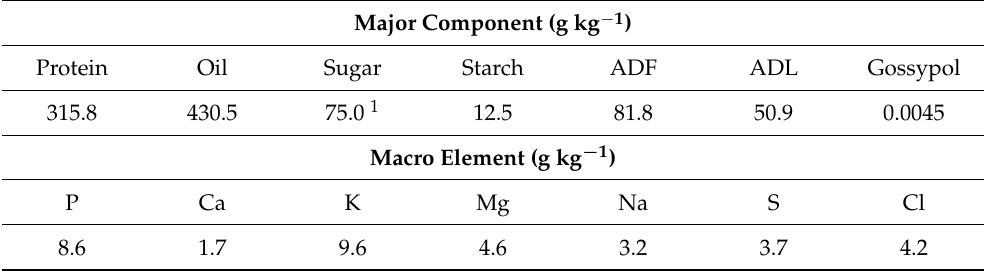
Table 4. Basic composition of cottonseed butter. Values were calculated per the composition data of the cottonseed kernels [7] and percentages of four ingredients (i.e., cottonseed, cottonseed oil, cane sugar, and table salt) in the butter formulation. ADF, acid detergent fiber. ADL, acid detergent